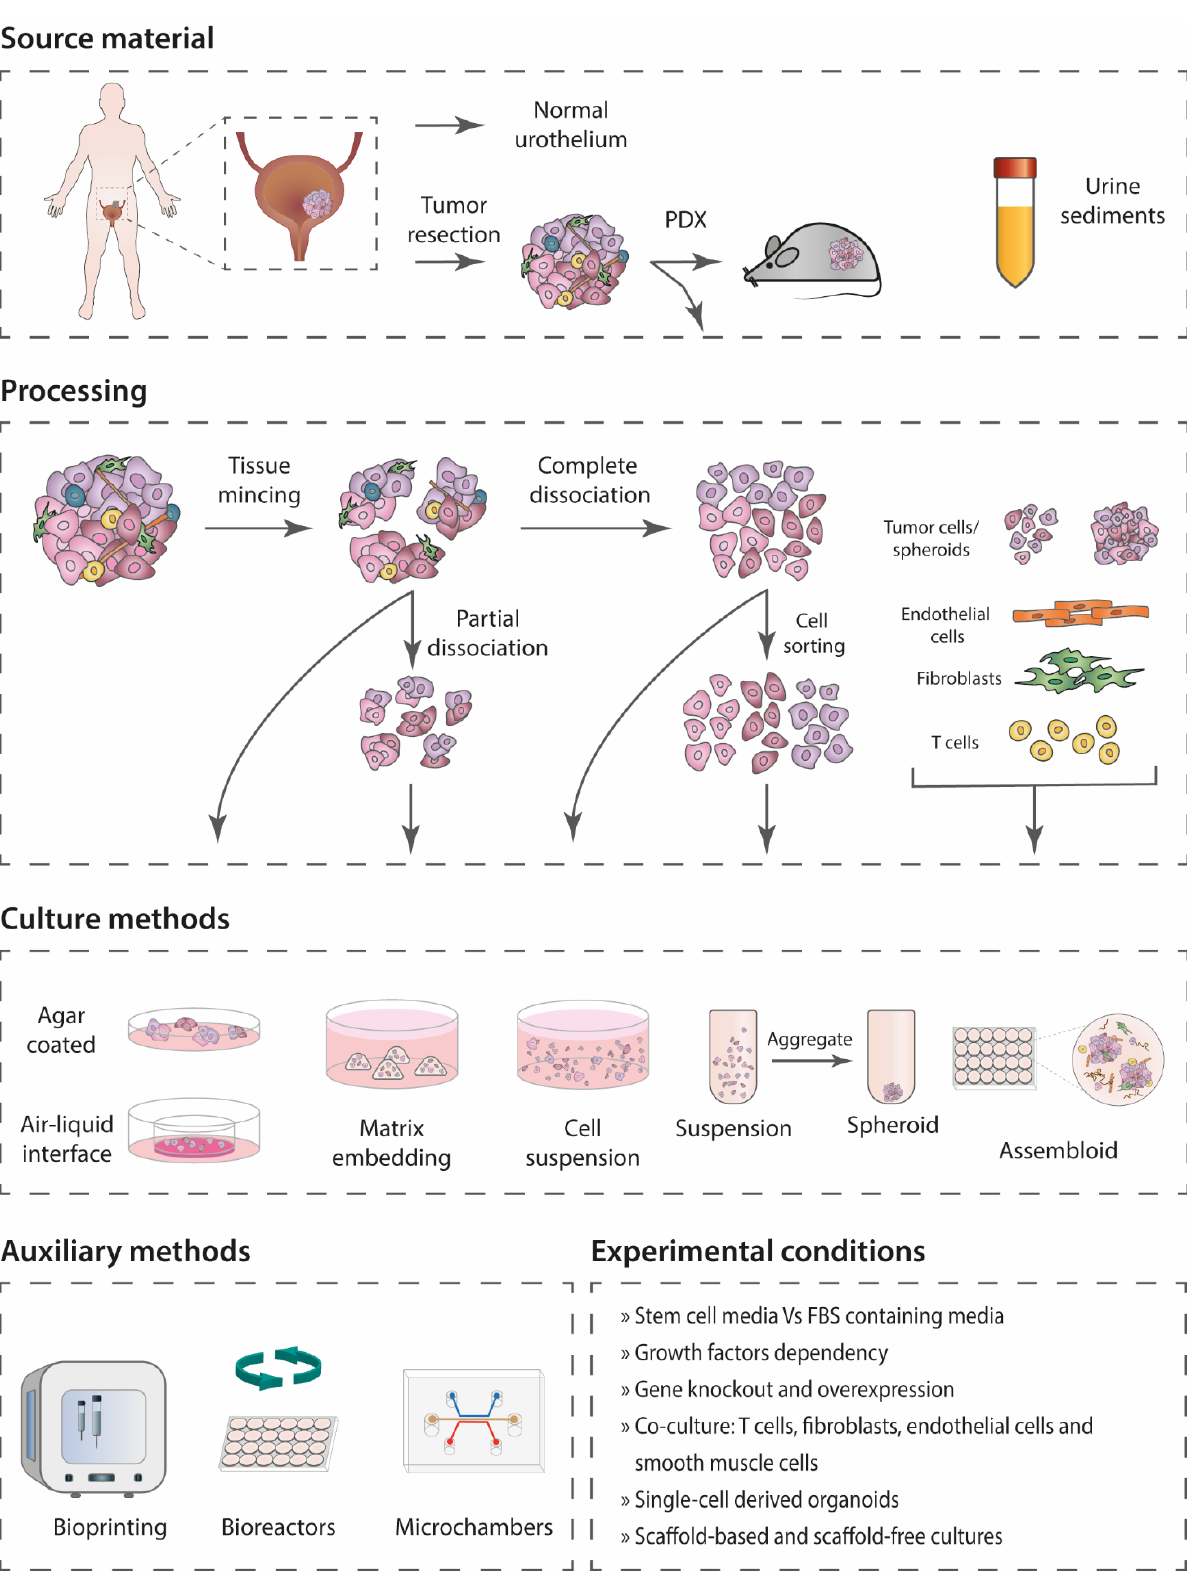
Figure 2. Overview of the different methods used for establishment of organoid models from nor- mal urothelium and bladder cancer cells. PDX: patient-derived xenografts.